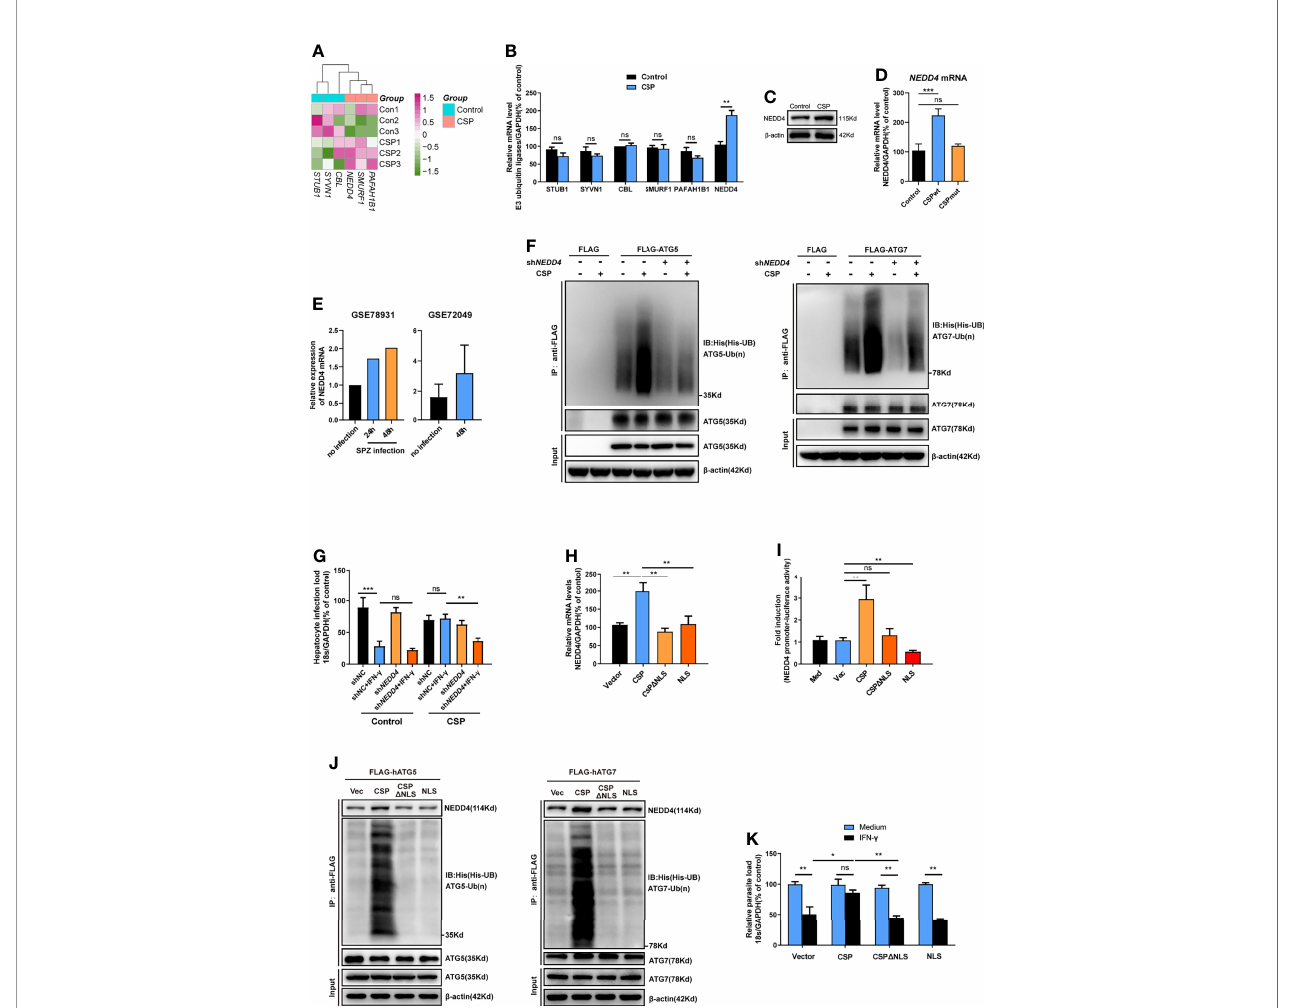
FIGURE 5 | CSP upregulates the E3 ubiquitin ligase NEDD4 to promote the ubiquitination of ATGs. (A) The mRNA levels of six E3 ubiquitin ligases between control and CSP-stably transfected HepG2 cells in the heatmap were compared, and three biological replicates were performed. (B) The different mRNA levels of six E3 ubiquitin ligases in both control and CSP-stably transfected HepG2 cells at 24 after culture were con fi rmed by real-time PCR. Three individual experiments have been performed. (C) The protein levels of NEDD4 in both control and CSP-stably transfected HepG2 cells at 24 after culture were con fi rmed by western blotting. Three individual experiments have been performed. (D) After HepG2 cells were infected with CSP wt or CSP mut sporozoites as described as before for 24 h, the mRNA level of NEDD4 was determined by real-time PCR, uninfected HepG2 cells were used as control. The experiment has been repeated for three times. (E) Relative level of NEDD4 mRNA in P.b ANKA sporozoite infected Huh7 and HepG2 cells were analyzed based on data extracted from GSE78931 and GSE72049. (F) Ubiquitination assay showed that sh NEDD4 deceased CSP-induced hATG5 ( left ) and hATG7 ( right ) ubiquitination in 293FT cells. 293FT cells were transfected with His-UB, pcDNA3.1 vector or pcDNA3.1-CSP, shNC or sh NEDD4 , and FLAG vector, FLAG-hATG5 or FLAG-hATG7 plasmids, and treated with MG-132 for 24 h. Then, cells were collected for immunoprecipitation of FLAG-hATG5 and FLAG-hATG7 followed by immunoblot analyses of ubiquitin (His-UB). Cells